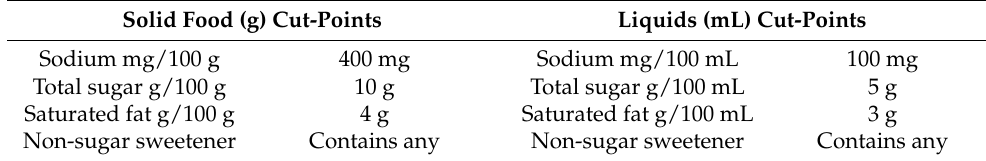
Table 5. Final proposed cut-points for an NPM suitable to be used in restrictive food policies in SA. Solid Food (g) Cut-Points Liquids (mL) Cut-Points Sodium mg/100 g 400 mg Sodium mg/100 mL 100 mg Total sugar g/100 g 10 g Total sugar g/100 mL Saturated fat g/100 g 4 g Saturated fat g/100 mL 3 g Non-sugar sweetener Contains any Non-sugar sweetener Contains